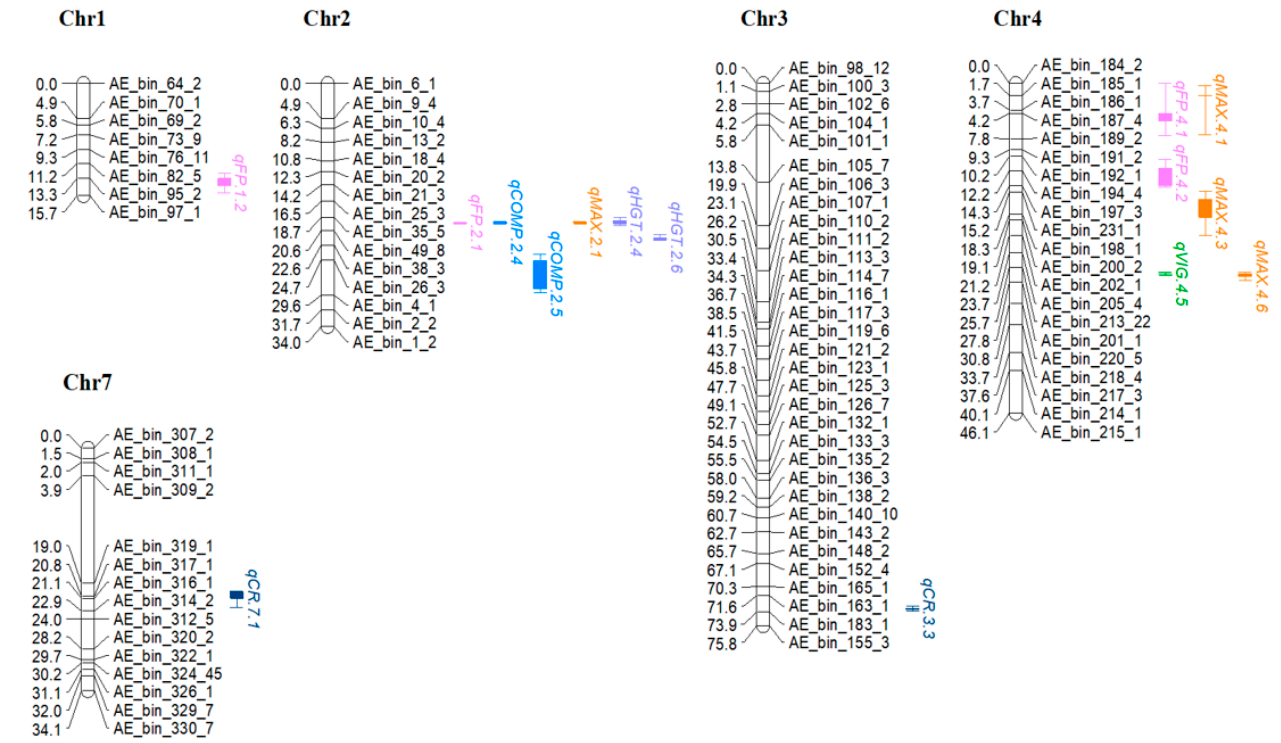
Figure 1. rQTL summary on chromosomes (Chr) 1-4 and 7 for growth and flowering traits evaluated at four locations in a P. axillaris × P. exserta F 7 recombinant inbred line population. Only a subset of bin markers is included to ease visualization. The shaded rectangle represents the range of peak positions, and the line segments represent combined confidence intervals at 1-LOD value.